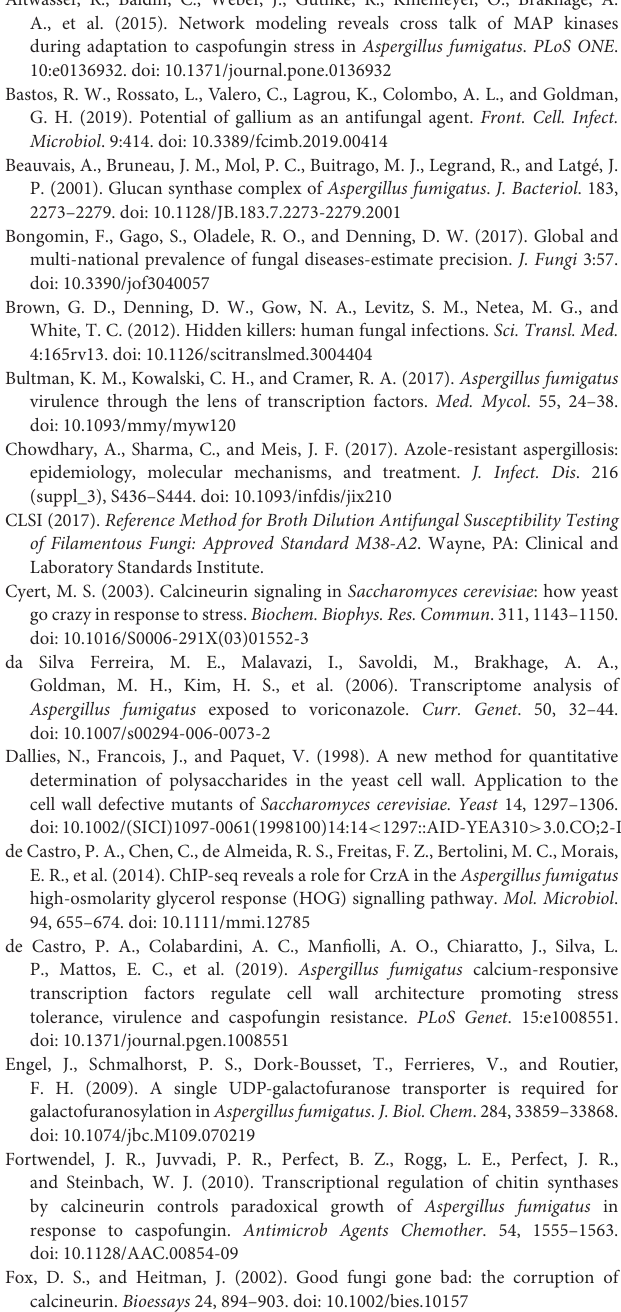
condition (control_exclusive) and unique to caspofungin condition (casofungin_exclusive). Supplementary Table 2 | MIC values and ranges ( µ g/ml) obtained by CLSI antifungal susceptibility testing method for the A. fumigatus strains included in this work. Supplementary Table 3 | List of primers used in this